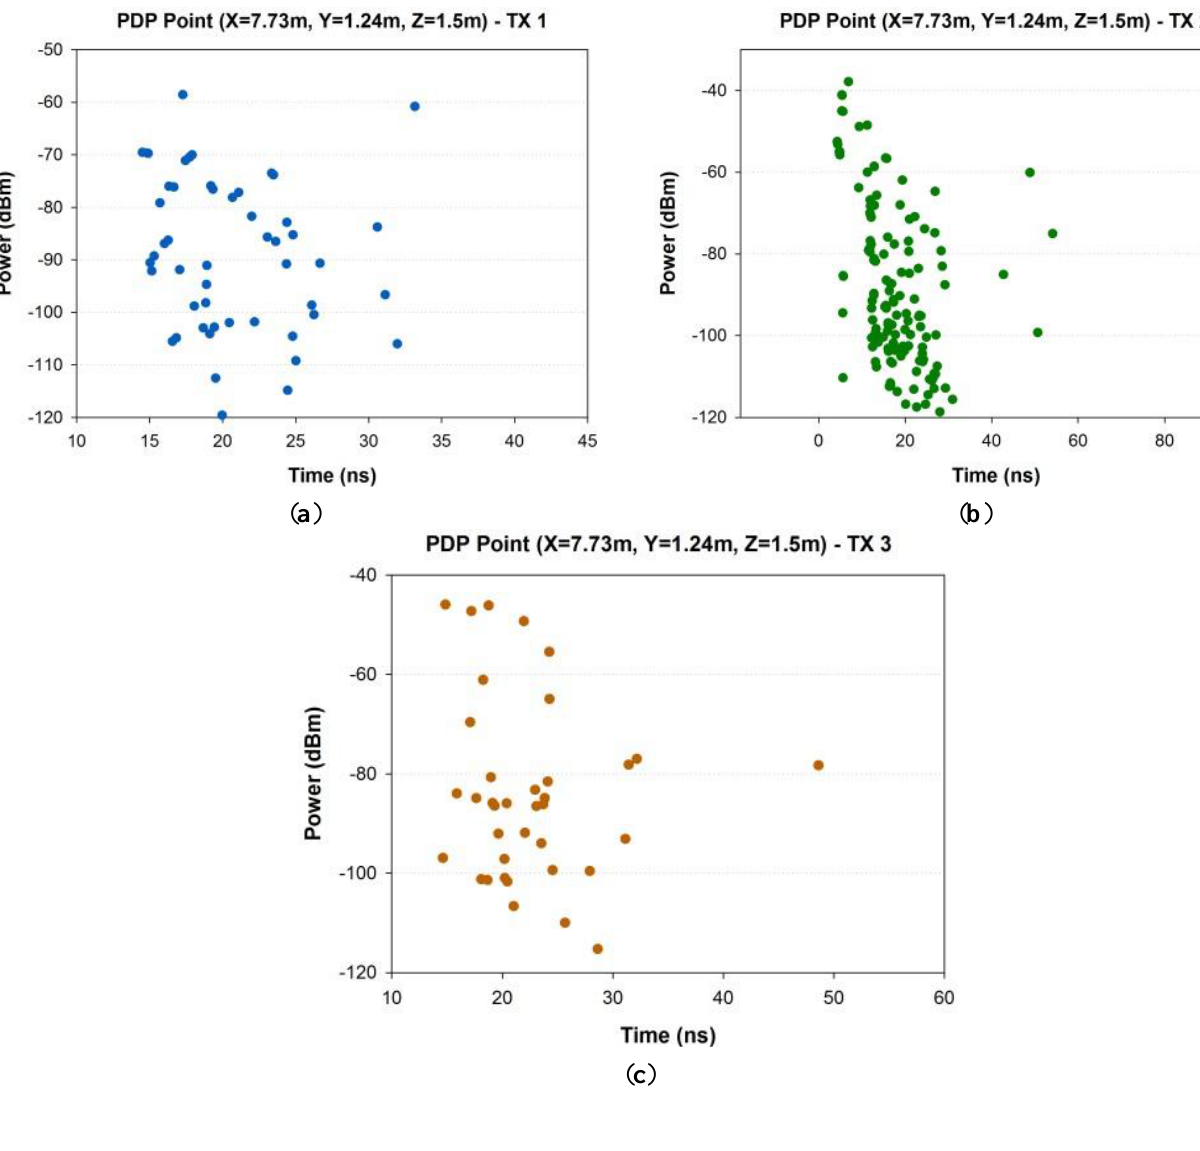
Figure 11. Power Delay Profile at a given cuboid, located at the central location in the ( c ) Transmitter 3 (slave